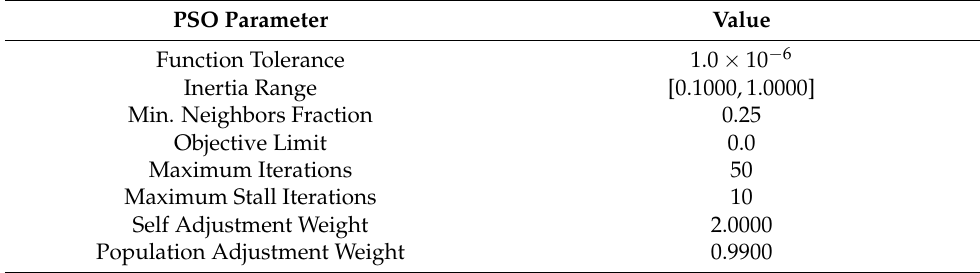
Table 2. Particle swarm optimization (PSO)